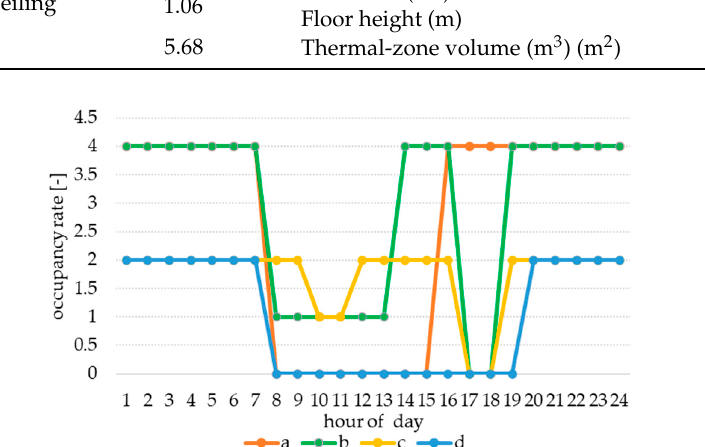
Figure 1. Single building representation in the SKETCHUP [79] environment.